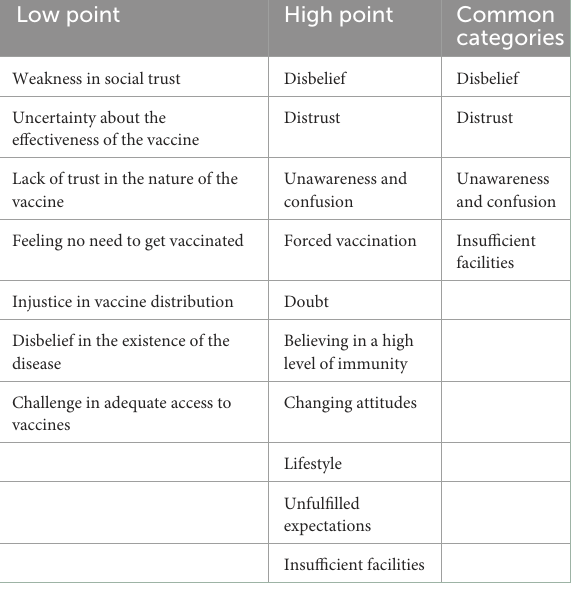
TABLE 1 Categories explored from the participants’ experiences about the vaccination in two low and high peaks. Low point High